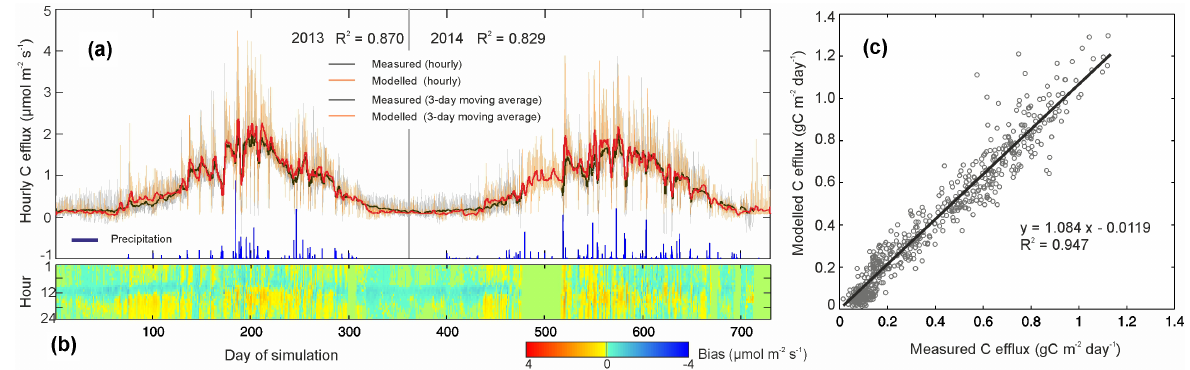
Figure 5. Measured and modelled hourly F S for non-crusted soil (a) , the temporal pattern of the bias of simulated hourly F S (b) and the comparison of measured and modelled daily F S (c) during